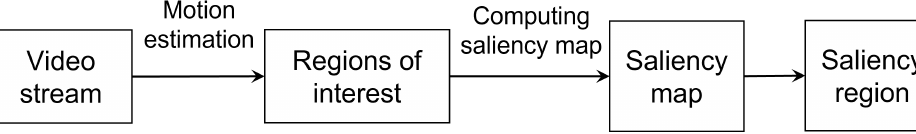
Figure 14. Flowchart for salient motion